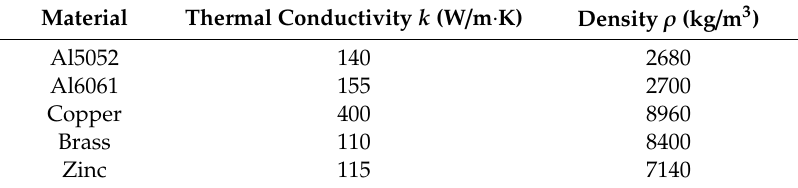
Table 3. The investigated radiator materials and their selected thermal and physical parameters [48].